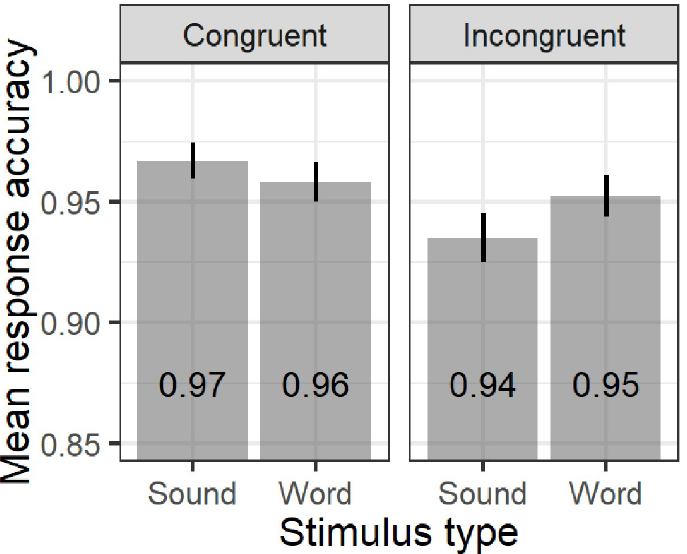
Fig 2. Mean response accuracy (aggregated by participants) as a function of stimulus type and congruency. Error bars without caps represent standard error of the means (SE).